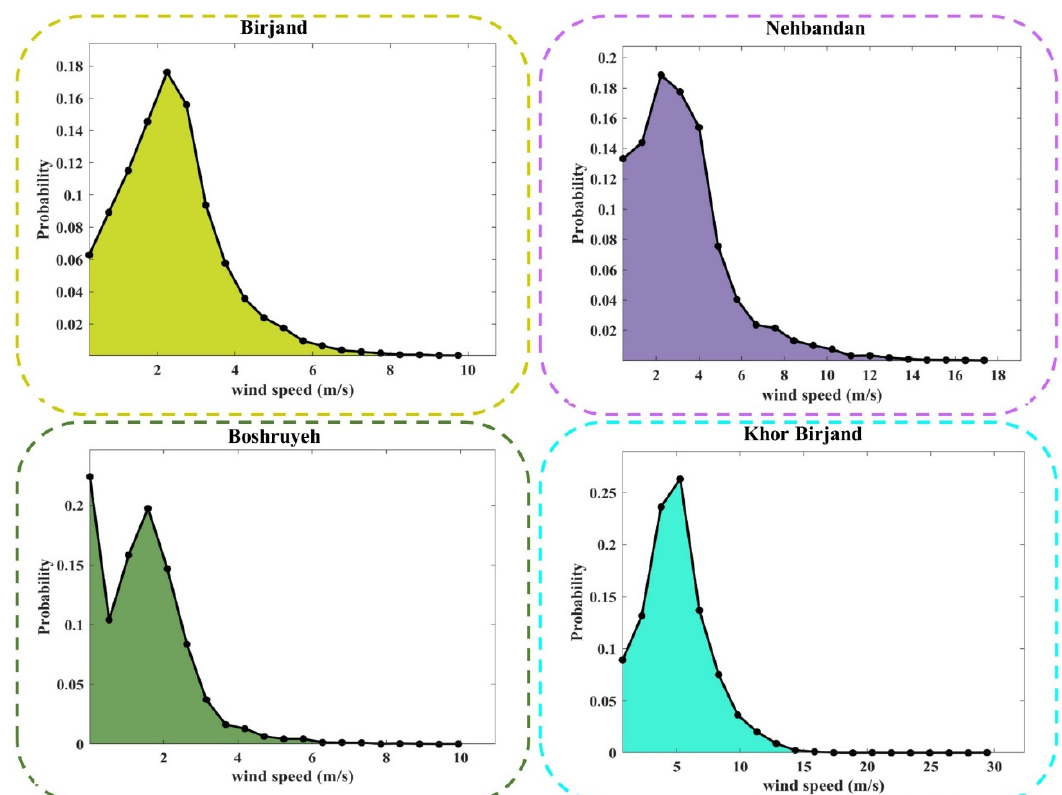
Figure A1. PDF plots of observed values of WS at different stations.